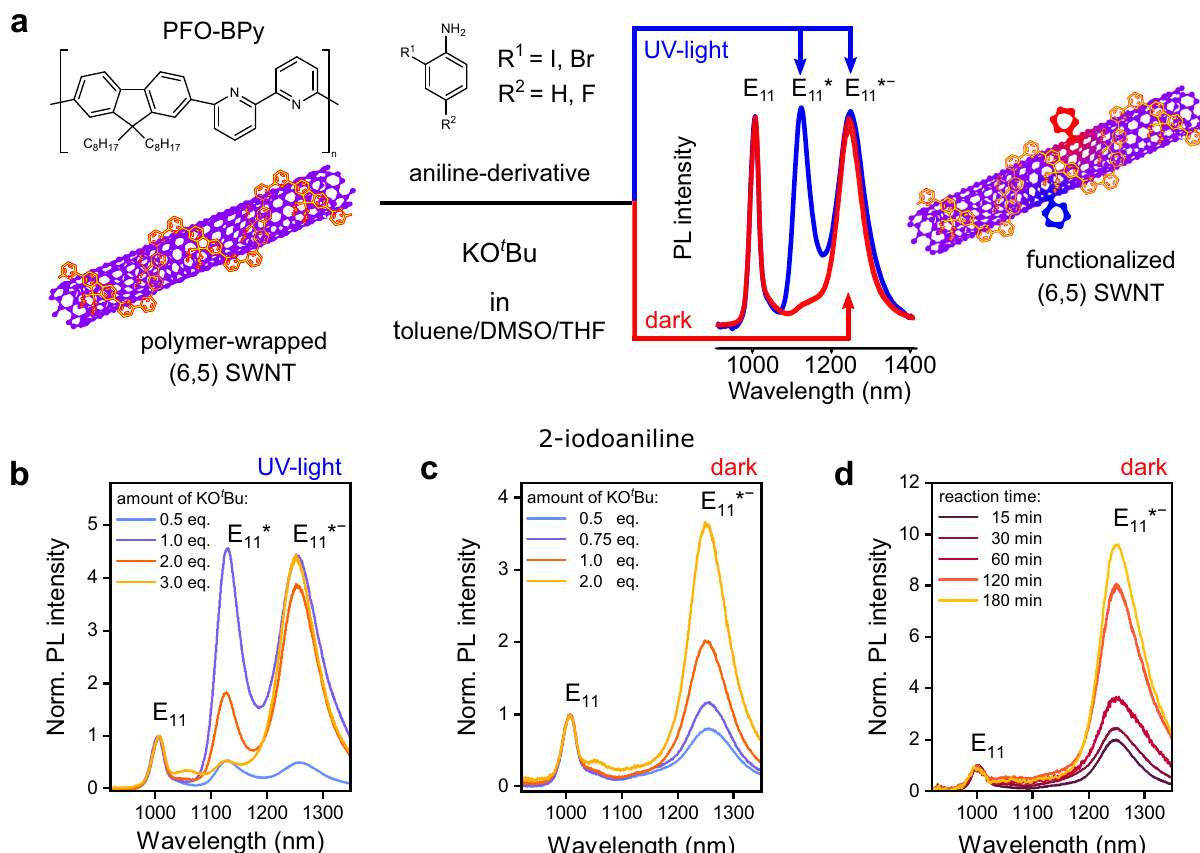
Fig. 1 Controlling sp 3 -defect emission from (6,5) SWNTs. a Scheme for functionalization of PFO-BPy-wrapped (6,5) SWNTs in toluene/DMSO/THF with aniline derivatives and base KO t Bu under UV-light irradiation (blue) and in the dark (red), respectively. Red-shifted defect emission bands are labeled as E 11 * (~1130 nm) and E 11 * − (~1250 nm). b , c PL spectra of (6,5) SWNTs functionalized with 2-iodoaniline and varying concentrations of KO t Bu under UV-light irradiation ( b ) and in the dark ( c ); reaction time 30 min. d Evolution of E 11 * − emission normalized to E 11 intensity for increasing reaction times with 2 eq. of KO t Bu in the dark. The concentration of 2-iodoaniline was kept at 29.30 mmol L − 1